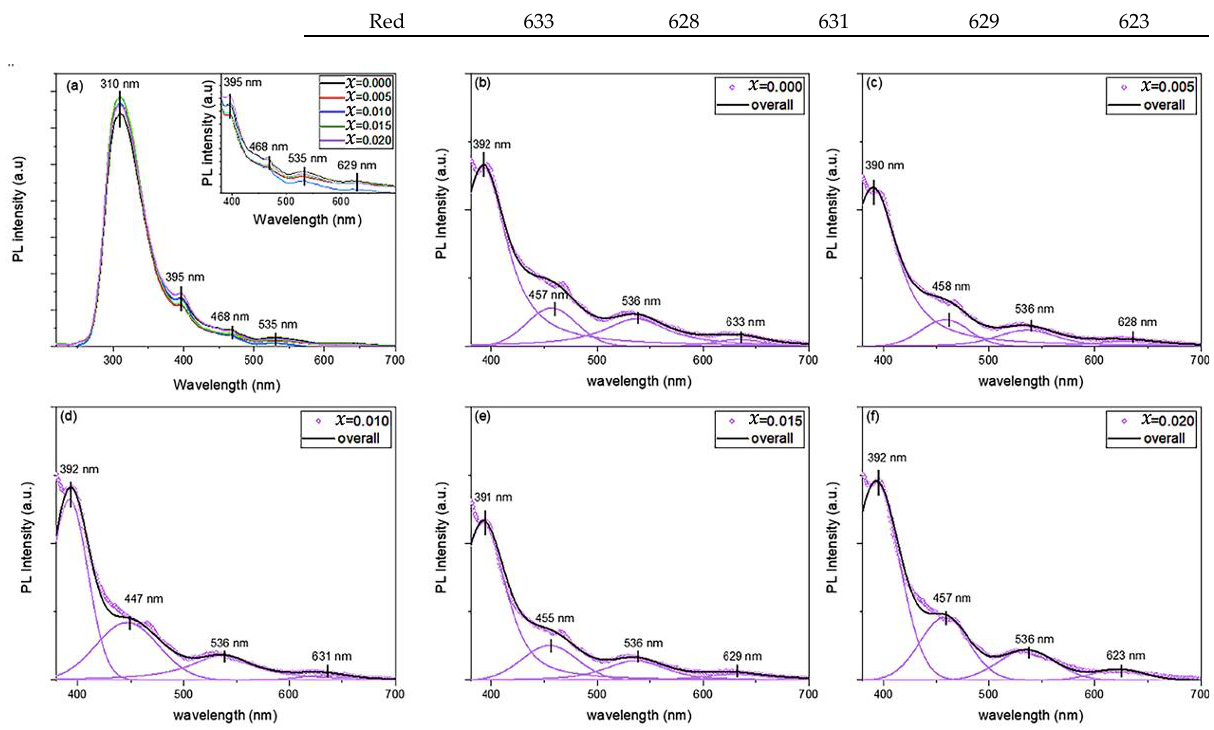
Figure 5. ( a ) Photoluminescence spectra of Cu 1 −x Mg x O NPs, and ( b – f ) their deconvolution for undoped and Mg-doped CuO NPs. Table 1. Position of peaks by deconvolution of PL spectra for Cu 1 − x Mg x O NPs. Peaks Color